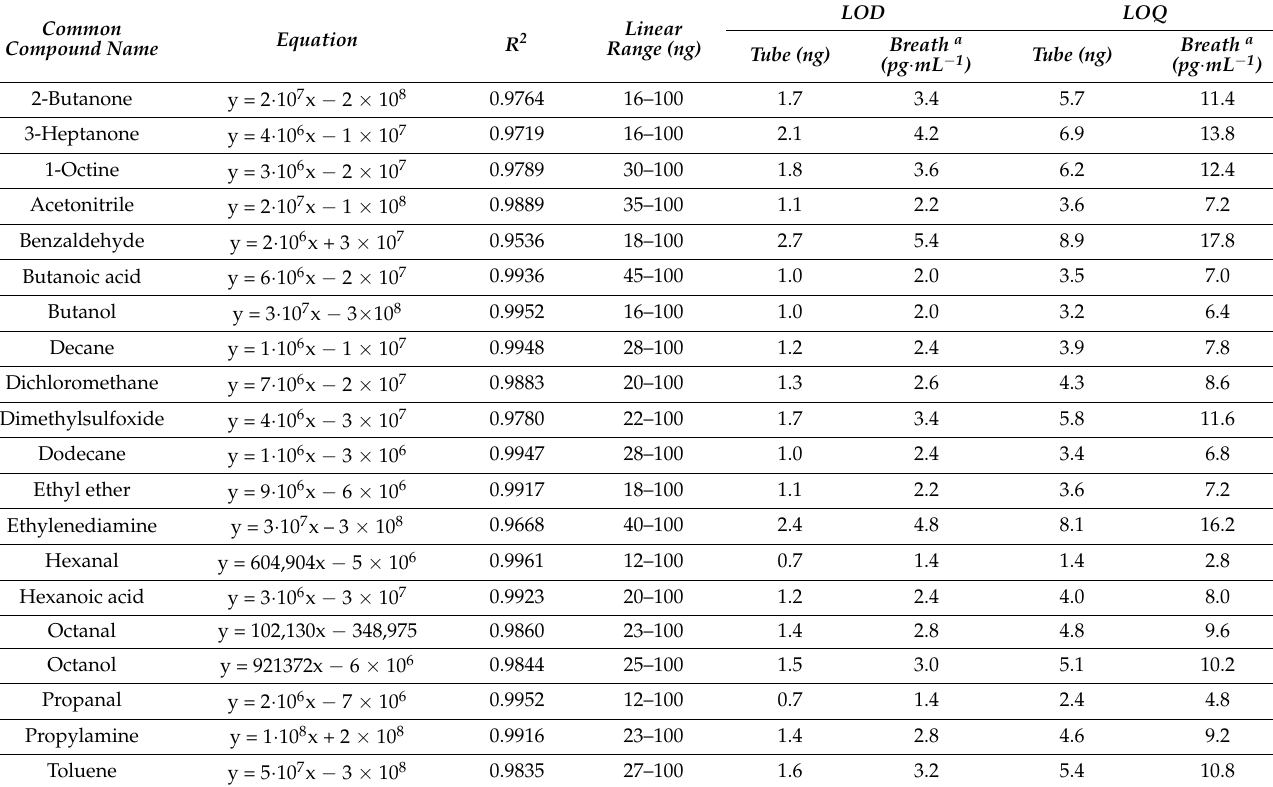
Table 4. Calibration curves equations, correlation coefficients (R 2 ), linear ranges, LOD, and LOQ values for selected VOCs.